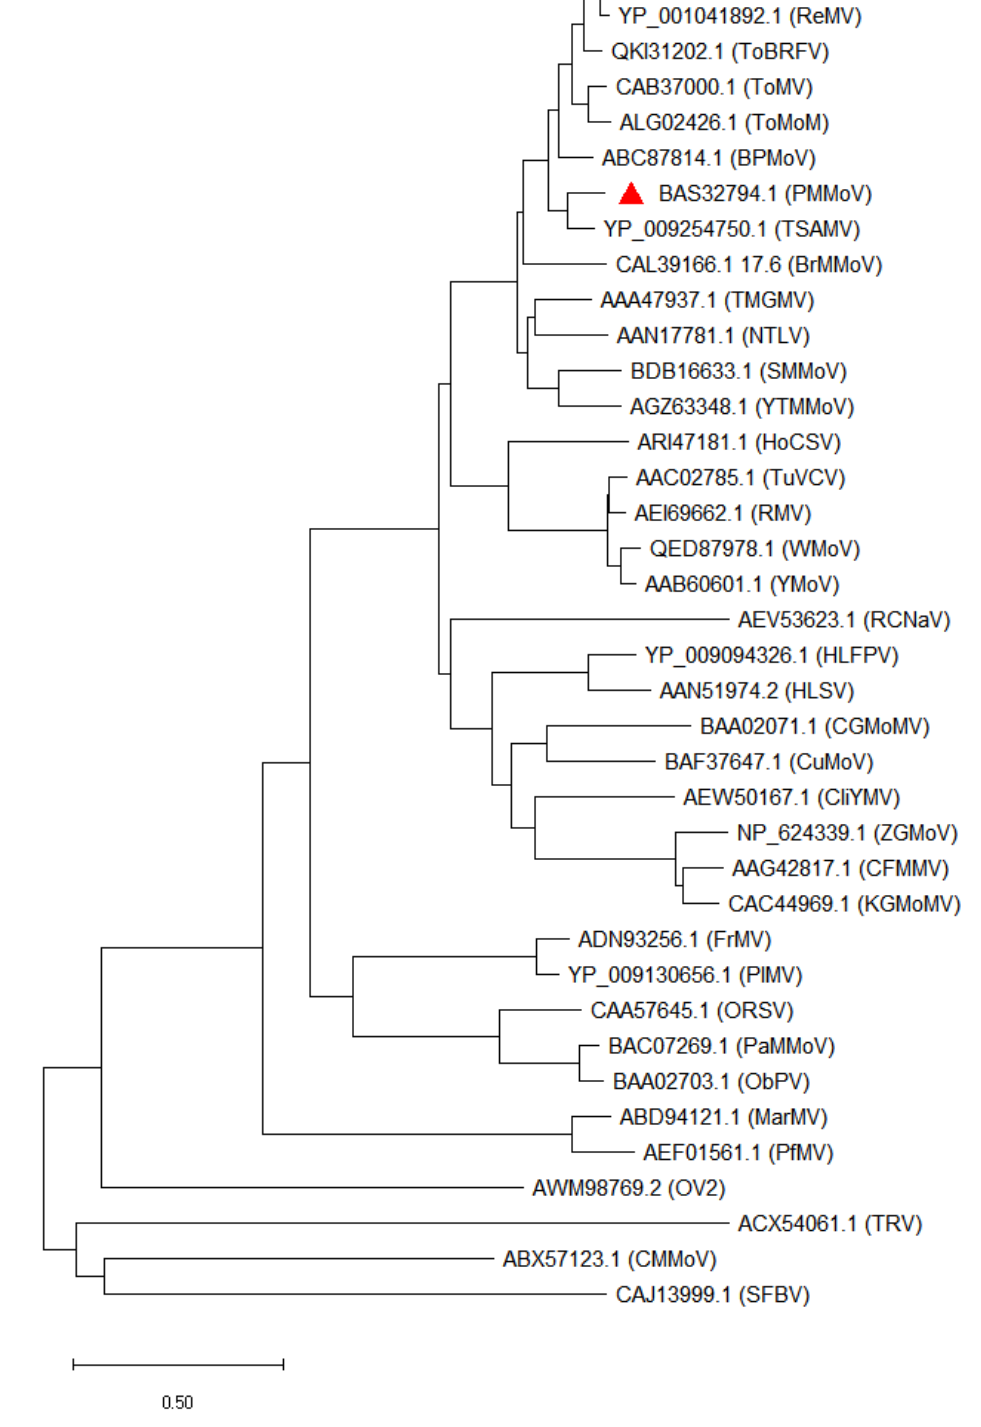
Figure 1. Unrooted phylogenetic tree of a representative isolate of pepper mild mottle virus (PMMoV) and other tobamoviruses based on sequences of their coat proteins (CPs). All the se- quences were downloaded from National Center for Biotechnology Information (NCBI) genome database (https://www.nvbi.nlm.nih.gov/) using the corresponding accession numbers. The phy- logenetic treewas constructed using MEGAX software. The red colored triangleindicatesPMMoV isolate. The representative isolates are indicated in parentheses against the corresponding protein accession numbers.